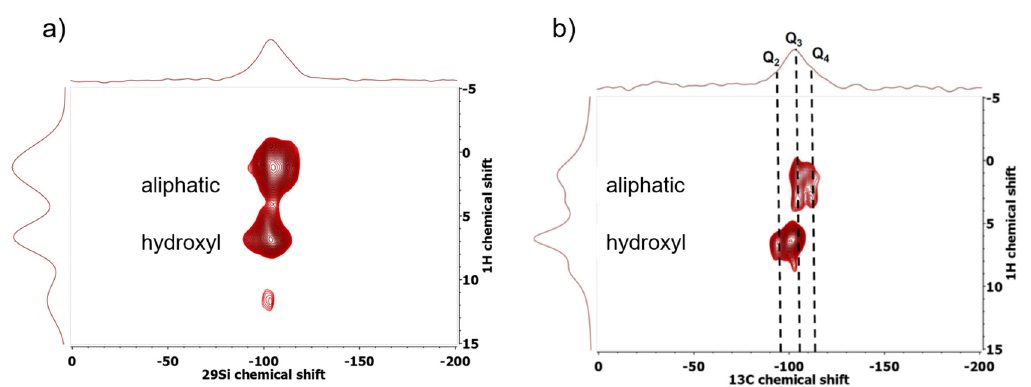
Figure 9. 2D 1 H- 29 Si FSLG HETCOR experiments of iBA / H 2 O mixtures confined in SBA-15 with contact times of ( a ) 3 ms (longer distances) and ( b ) 0.5 ms (shorter distances) clearly reveal that both hydroxy- and aliphatic protons are in contact with the surface silicon nuclei (56 wt % iBA, 9.4Tesla, 100 K, 8 kHz MAS, 89 kHz FSLG homonuclear decoupling [257]). (Figure adapted from [256]).